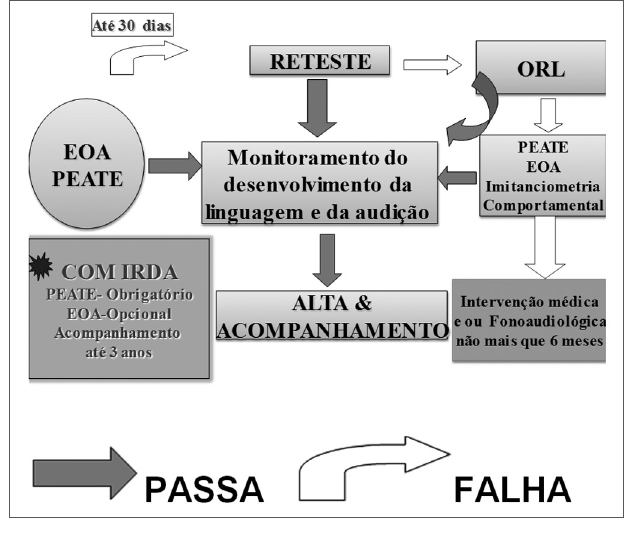
Figura 1. Algoritmo da